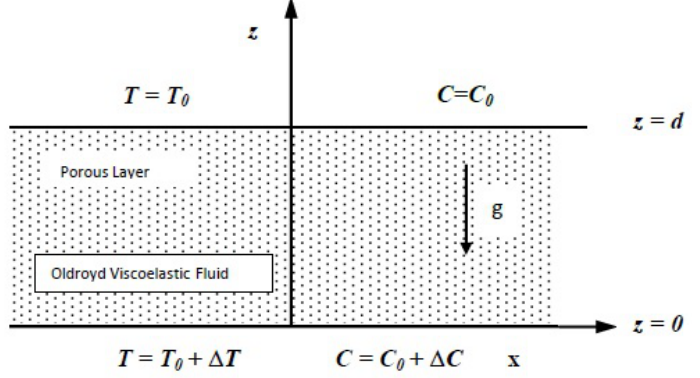
Figure 1. Physical configuration of the